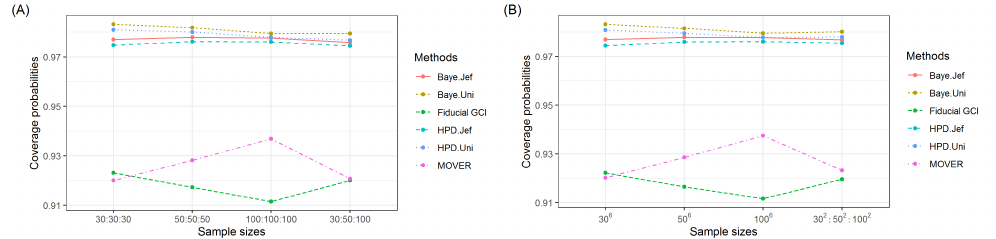
Figure 2. Coverage probabilities of the 95% simultaneous CIs with various sample sizes: ( A ) k = 3 and ( B ) k = 6.